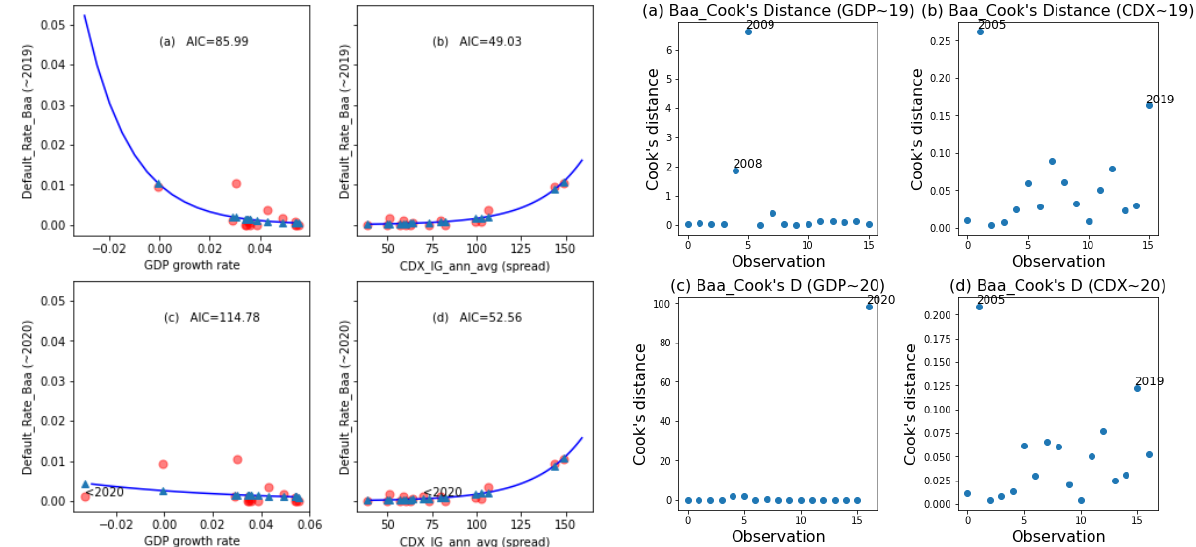
Figure 7. Fitted logistic regression models ( left panel ) and Cook’s distances ( right panel ) of default rate in relation to ( a ) GDP in 2004–2019 data; ( b ) CDX.NA.IG in 2004–2019 data; ( c ) GDP in 2004–2020 data; and ( d ) CDX.NA.IG in 2004–2020 data (spread) for Baa class ratings.